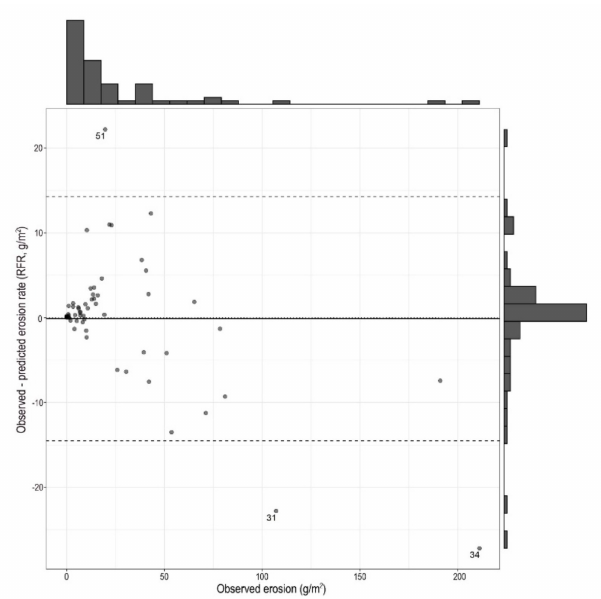
Figure 8. Bland–Altman diagram of the random forest regression (RFR) model predicted with repeated cross validation (RCV) approach based on 50 models (...: zero di ff erence; –: mean, - - -: 2 × standard deviation, labelled cases: di ff erence was larger than 2 × standard deviation (SD)).